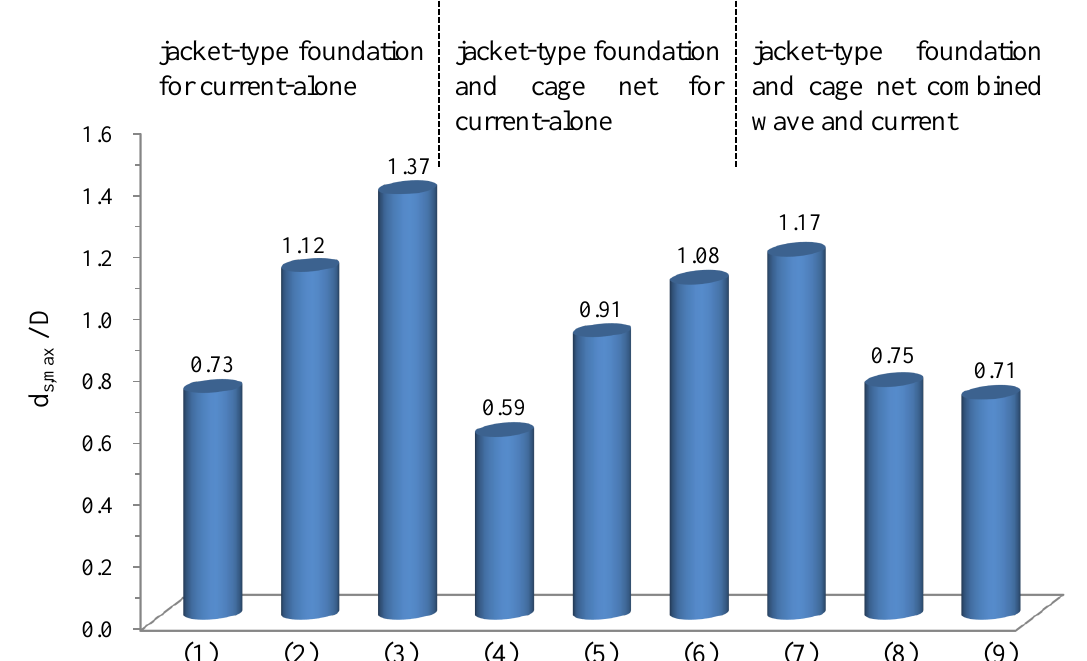
Figure 10. The maximum scour depths under the different test conditions for the jacket-type foundation and coastal cage